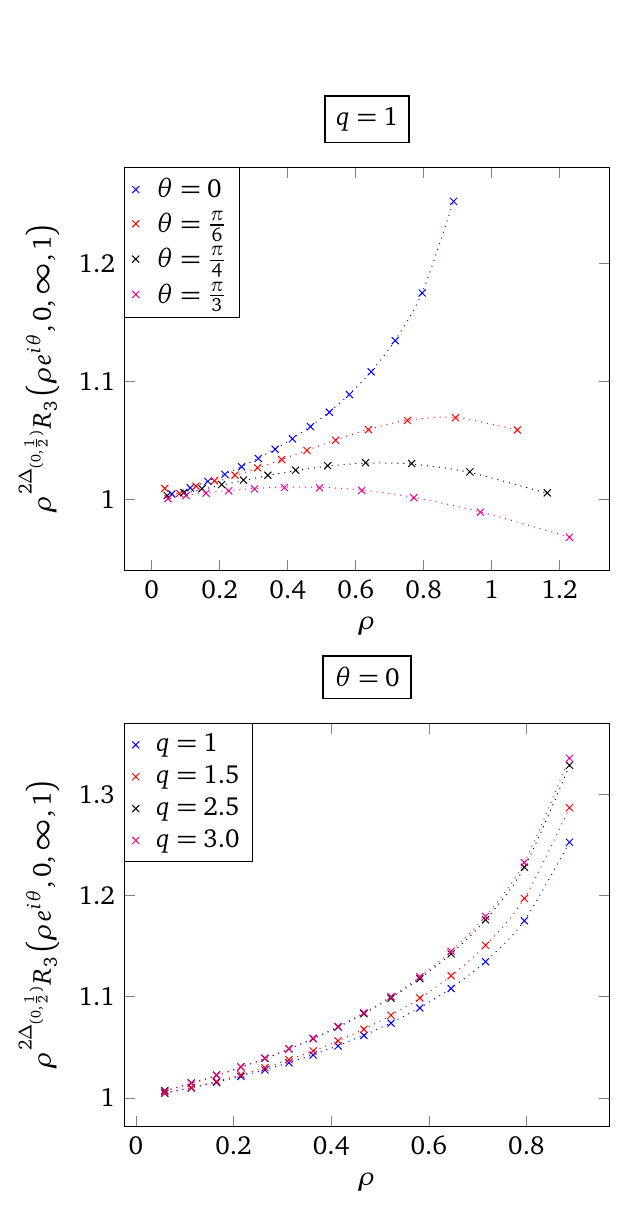
Figure 1: R vs. ρ for c = 0 and θ = 0, π/ 6, π/ 4, π/ 3, and for θ = 0 and q ∈ { 1,1.5,2.5,3 } . 3 Crosses correspond to the Monte-Carlo simulations. The dotted lines show the bootstrap solu- tion, obtained by truncating the spectrum at N = 6 states and the expansion of the conformal blocks at level L =